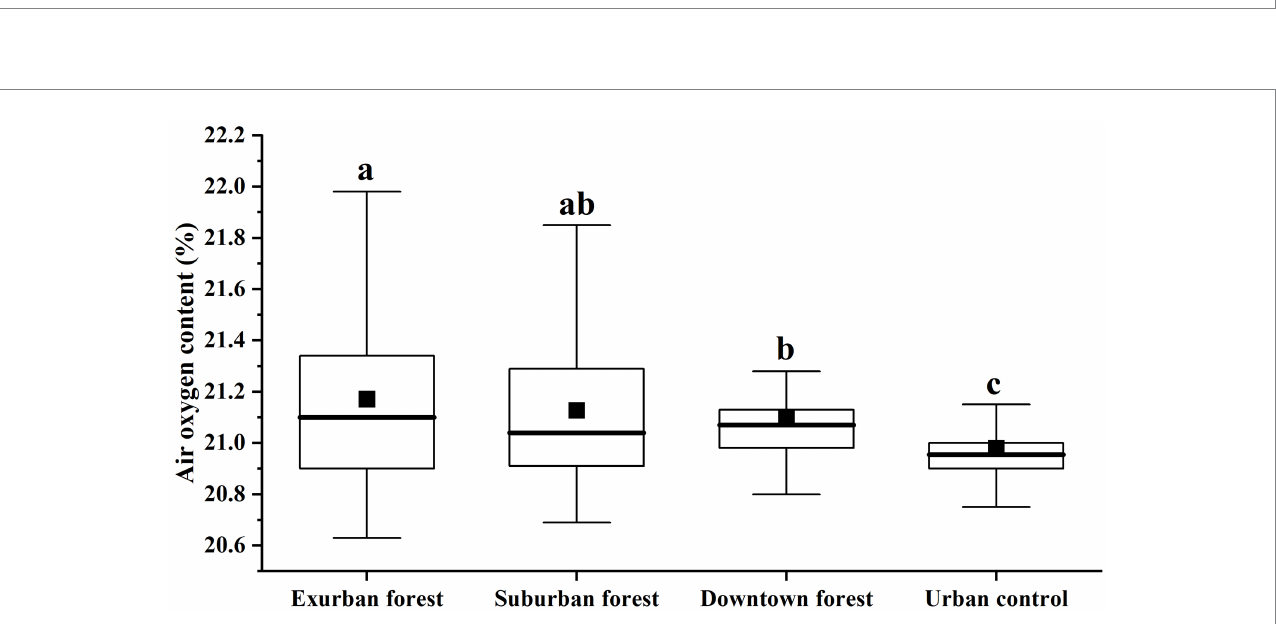
FIGURE 5 Comparison of annual average of AOC of urban forests in different geographical